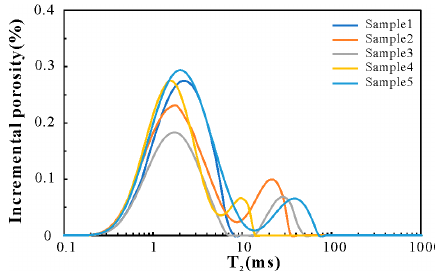
Figure 5. The saturated NMR T 2 spectra of samples. Figure 5 . The saturated NMR T 2 spectra of samples. Figure 5 . The saturated NMR T 2 spectra of samples.